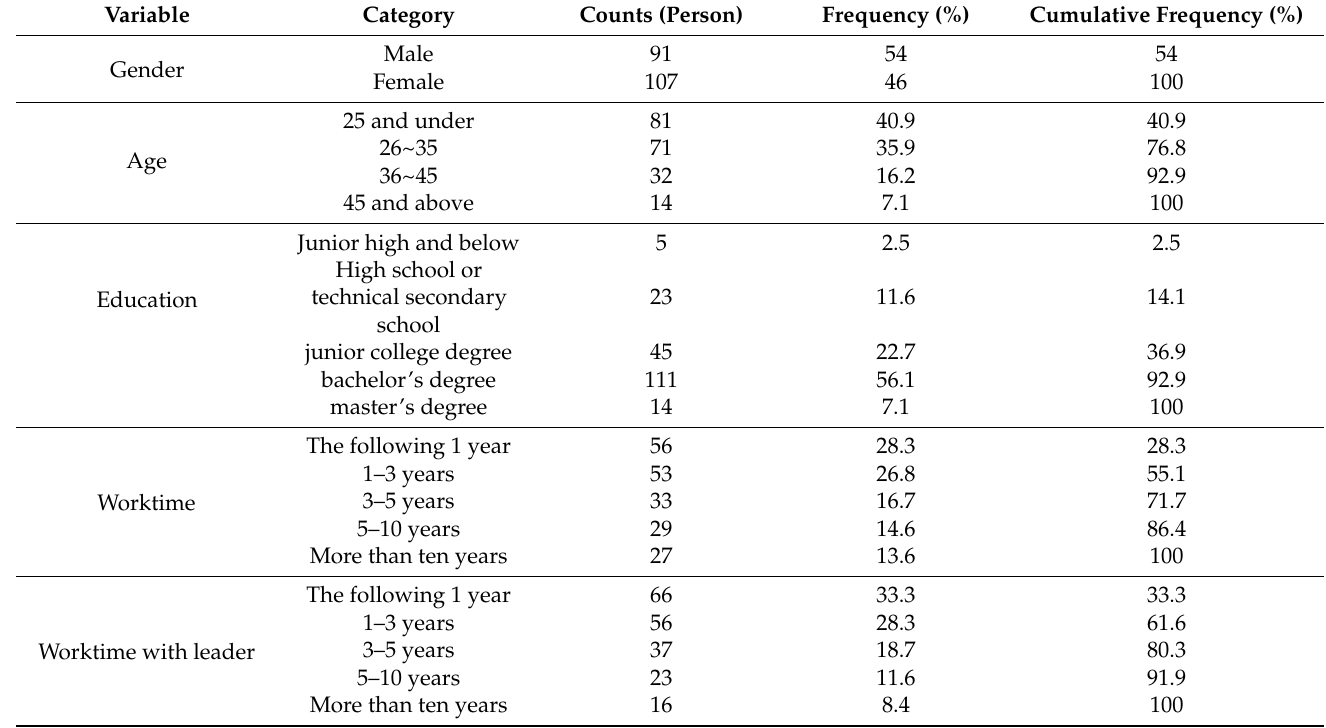
Table A1. Study 1 Valid sample